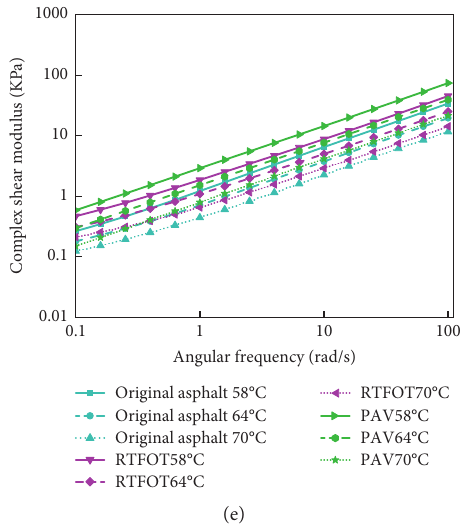
Figure 6: Frequency sweep G ∗ curve of each asphalt. (a) K1. (b) K2. (c) G1. (d) G2. (e)